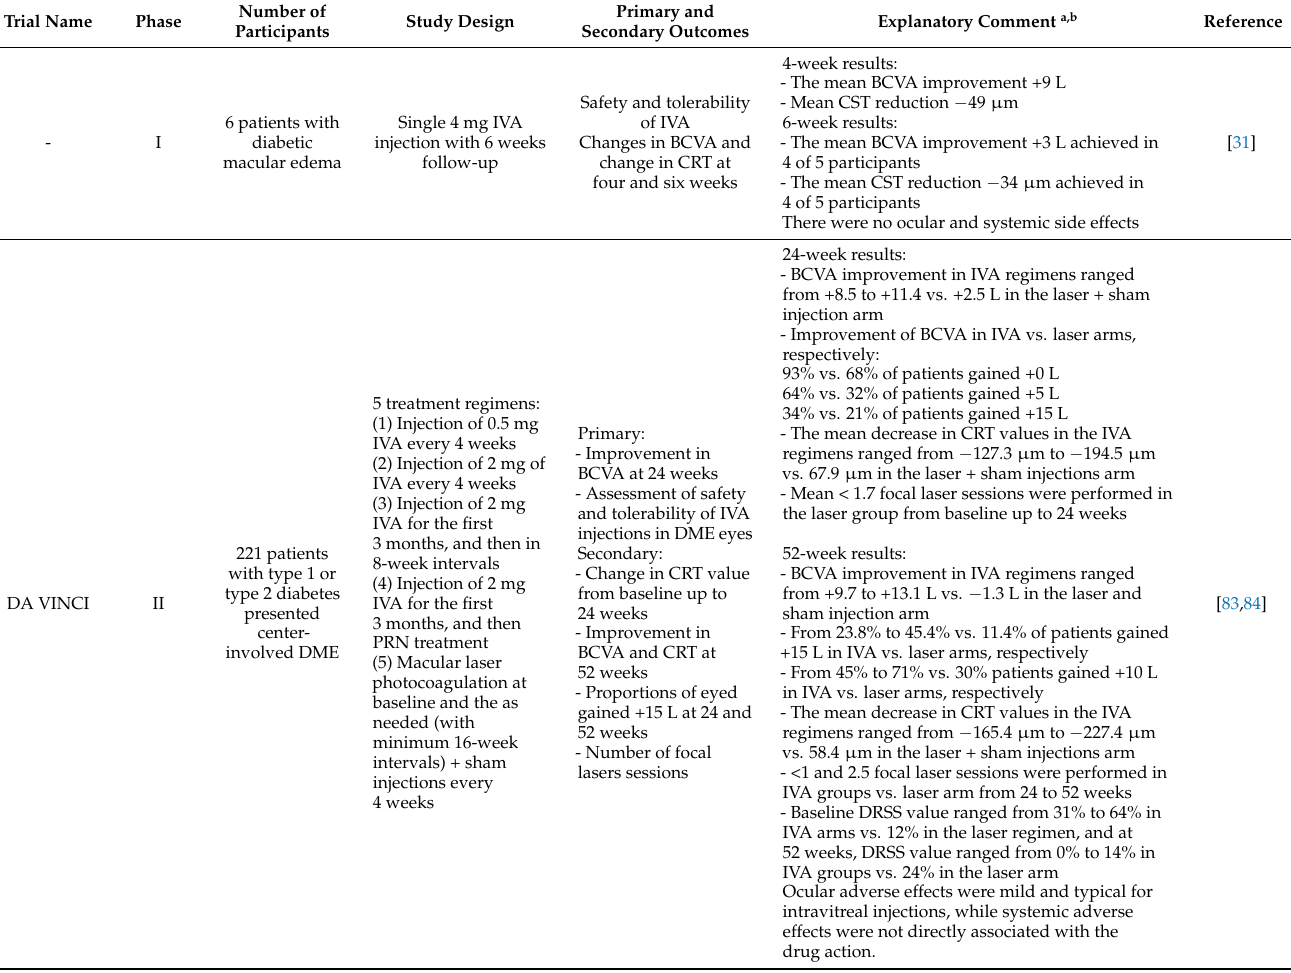
Table 3. Summary of clinical trials assessing the use of aflibercept in the treatment of